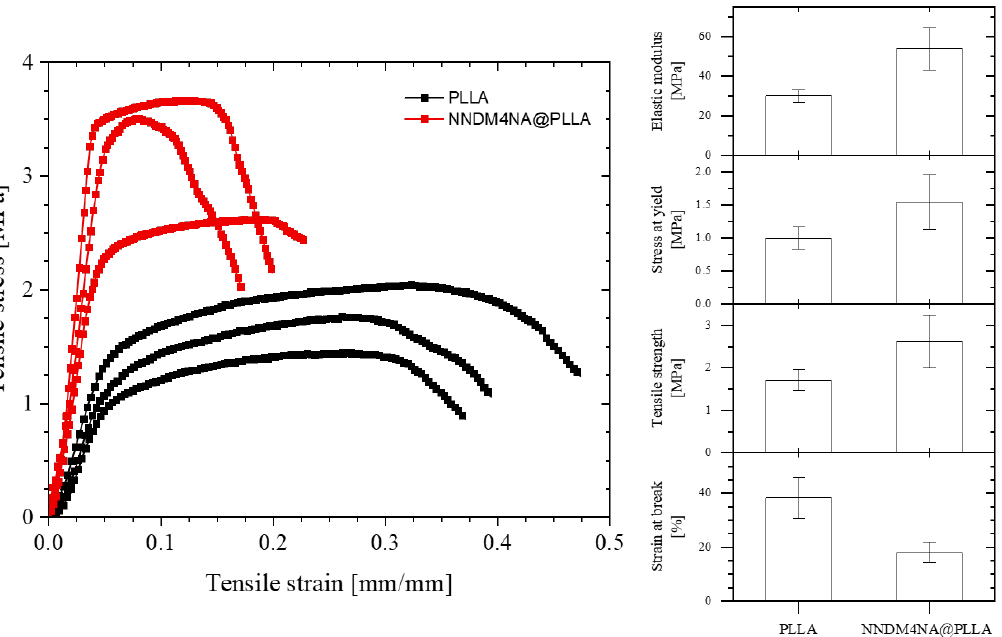
Figure 4. Elastic modulus, stress at yield, tensile strength and strain at break of PLLA and NNDM4NA@PLLA electrospun fibers.